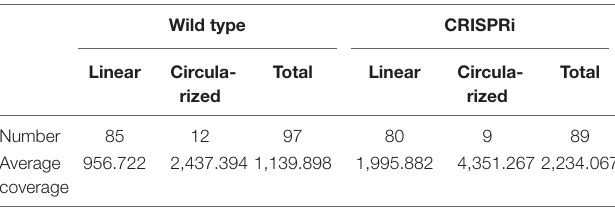
TABLE 6 | Introns in wild type and CRISPRi